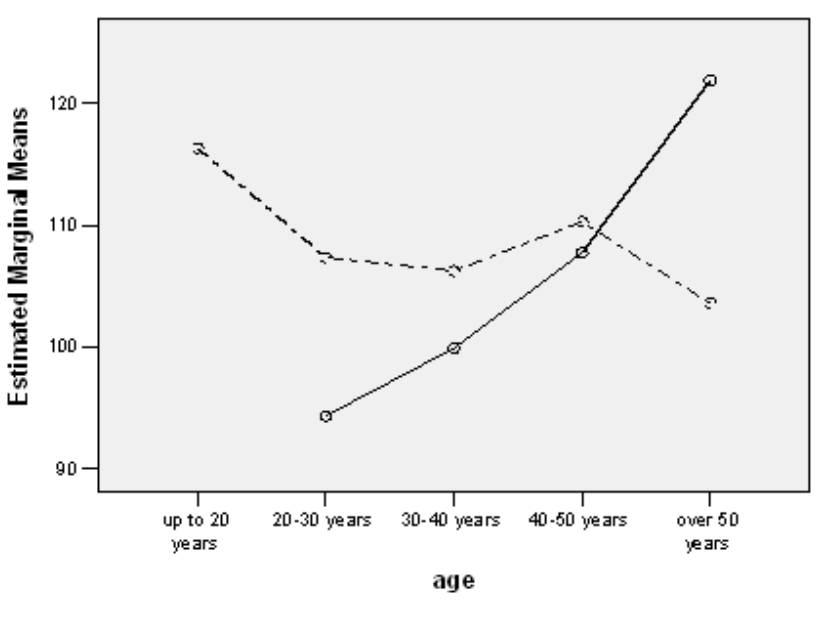
Figure 80: Presentation of paper Figure 2. The peculiarities of psychological safety of the educational environment of participants in the educational process depending on age and professional status